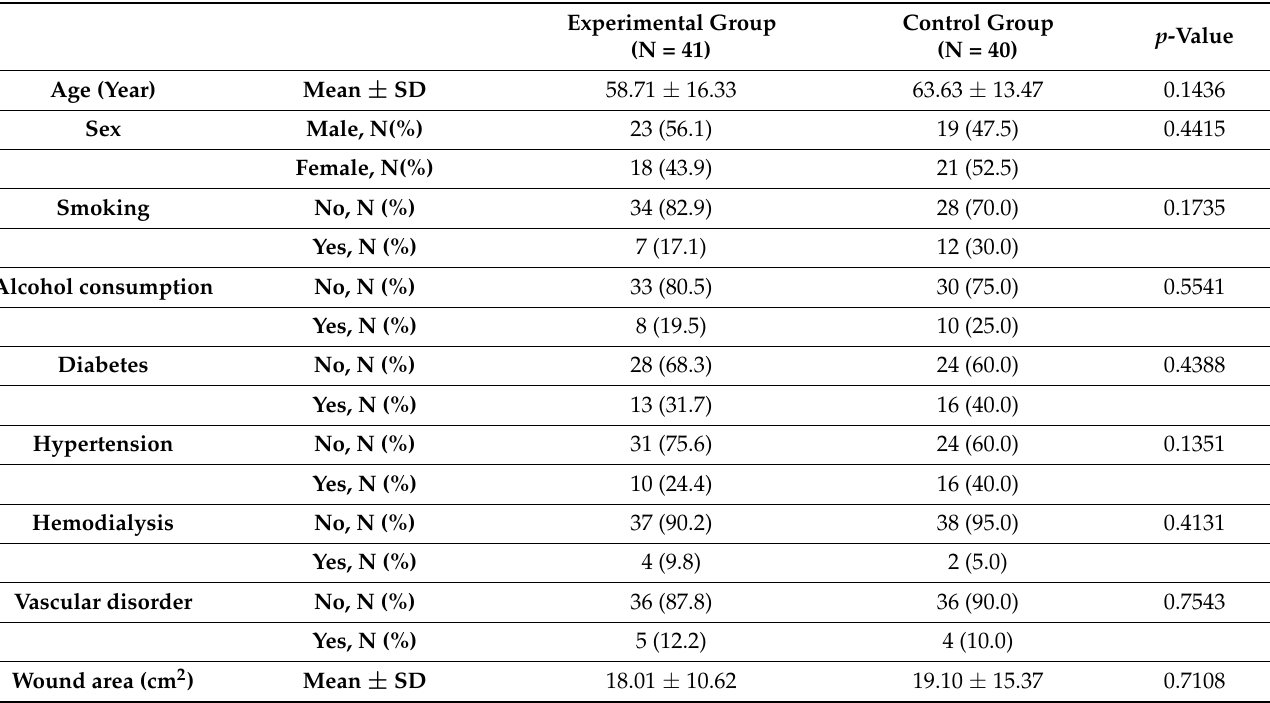
Table 2. Demographic characteristics.